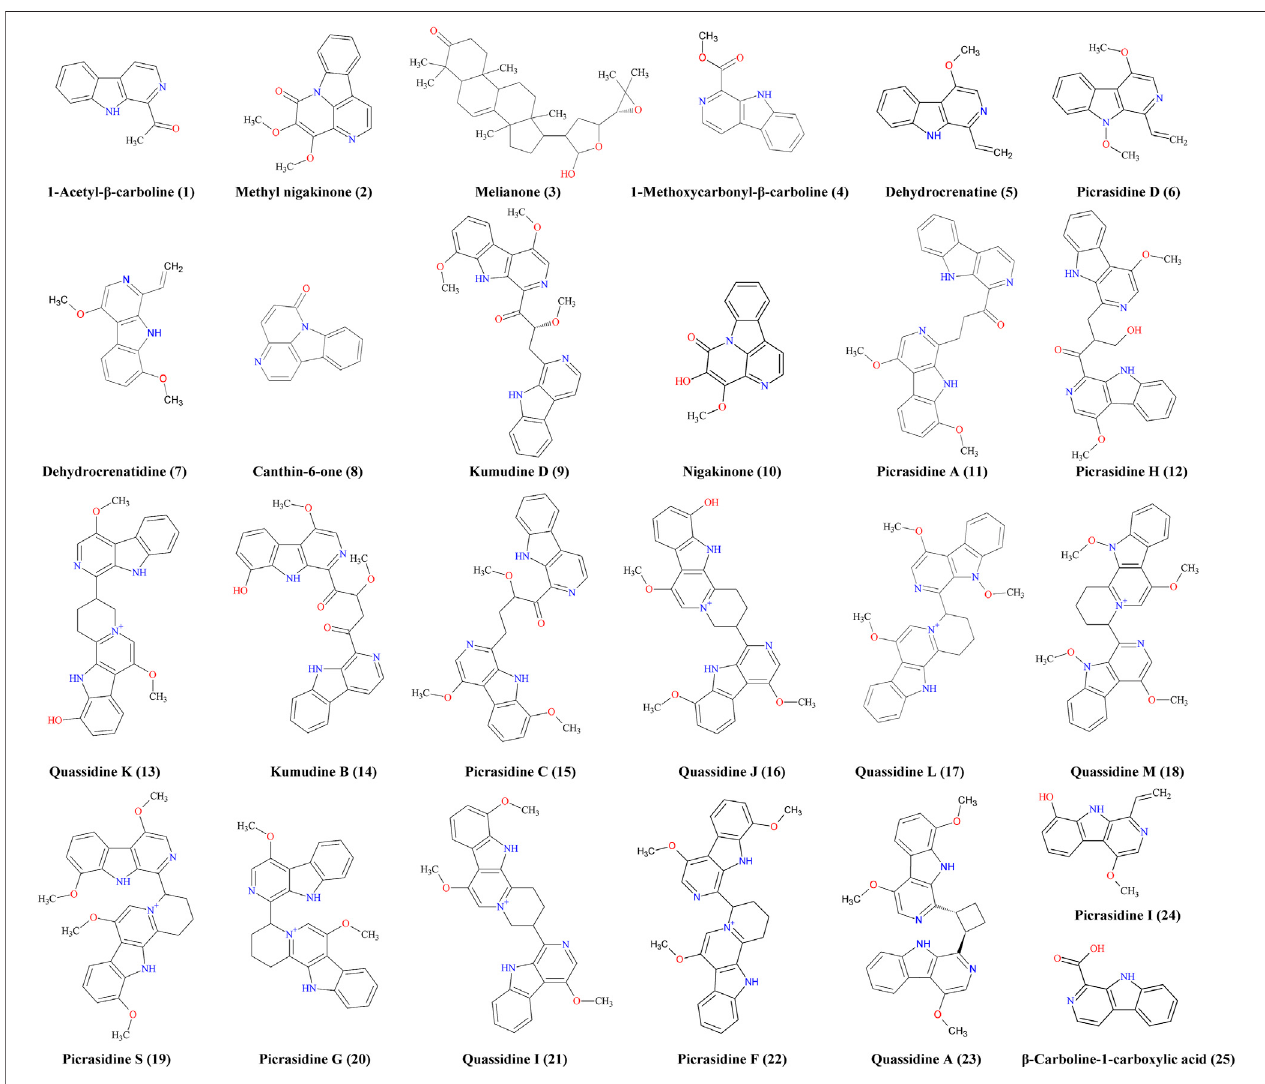
FIGURE 4 | Antimicrobial chemicals identi fi ed from the stem of Picrasma quassioides .